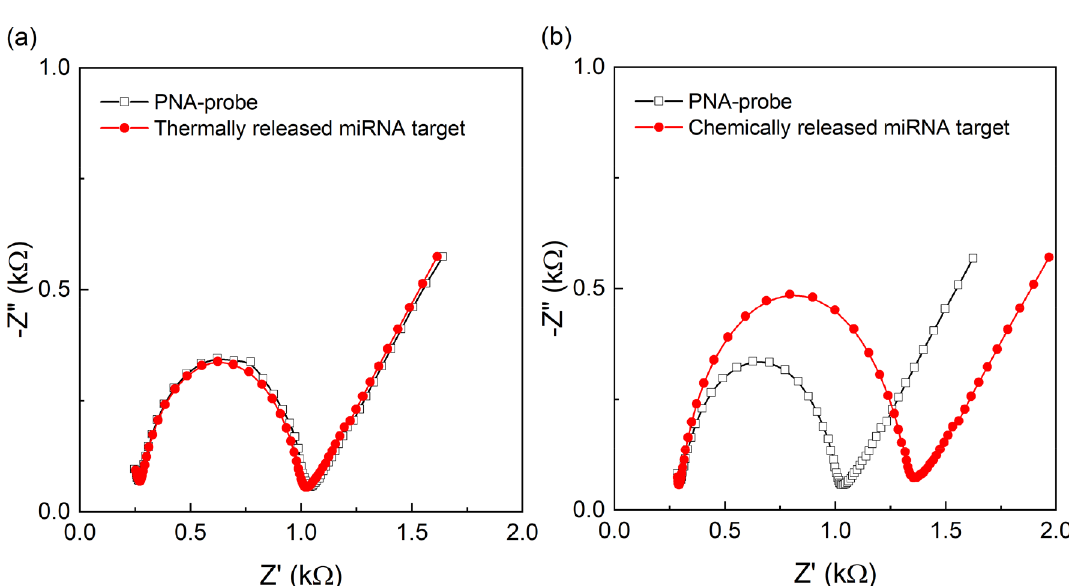
Figure 5. ( a ) EIS characterization of the PNA immobilized probe and its stability in blank buffer followed by hybridization with solution that contains thermally released miRNA from magnetic beads surface. ( b ) EIS characterization of the PNA immobilized probe and its stability in blank buffer followed by hybridization with chemically released miRNA from magnetic beads surface. All measurements were performed in 10 mM PB with 10 mM [Fe(CN) 6 ] 3−/4−